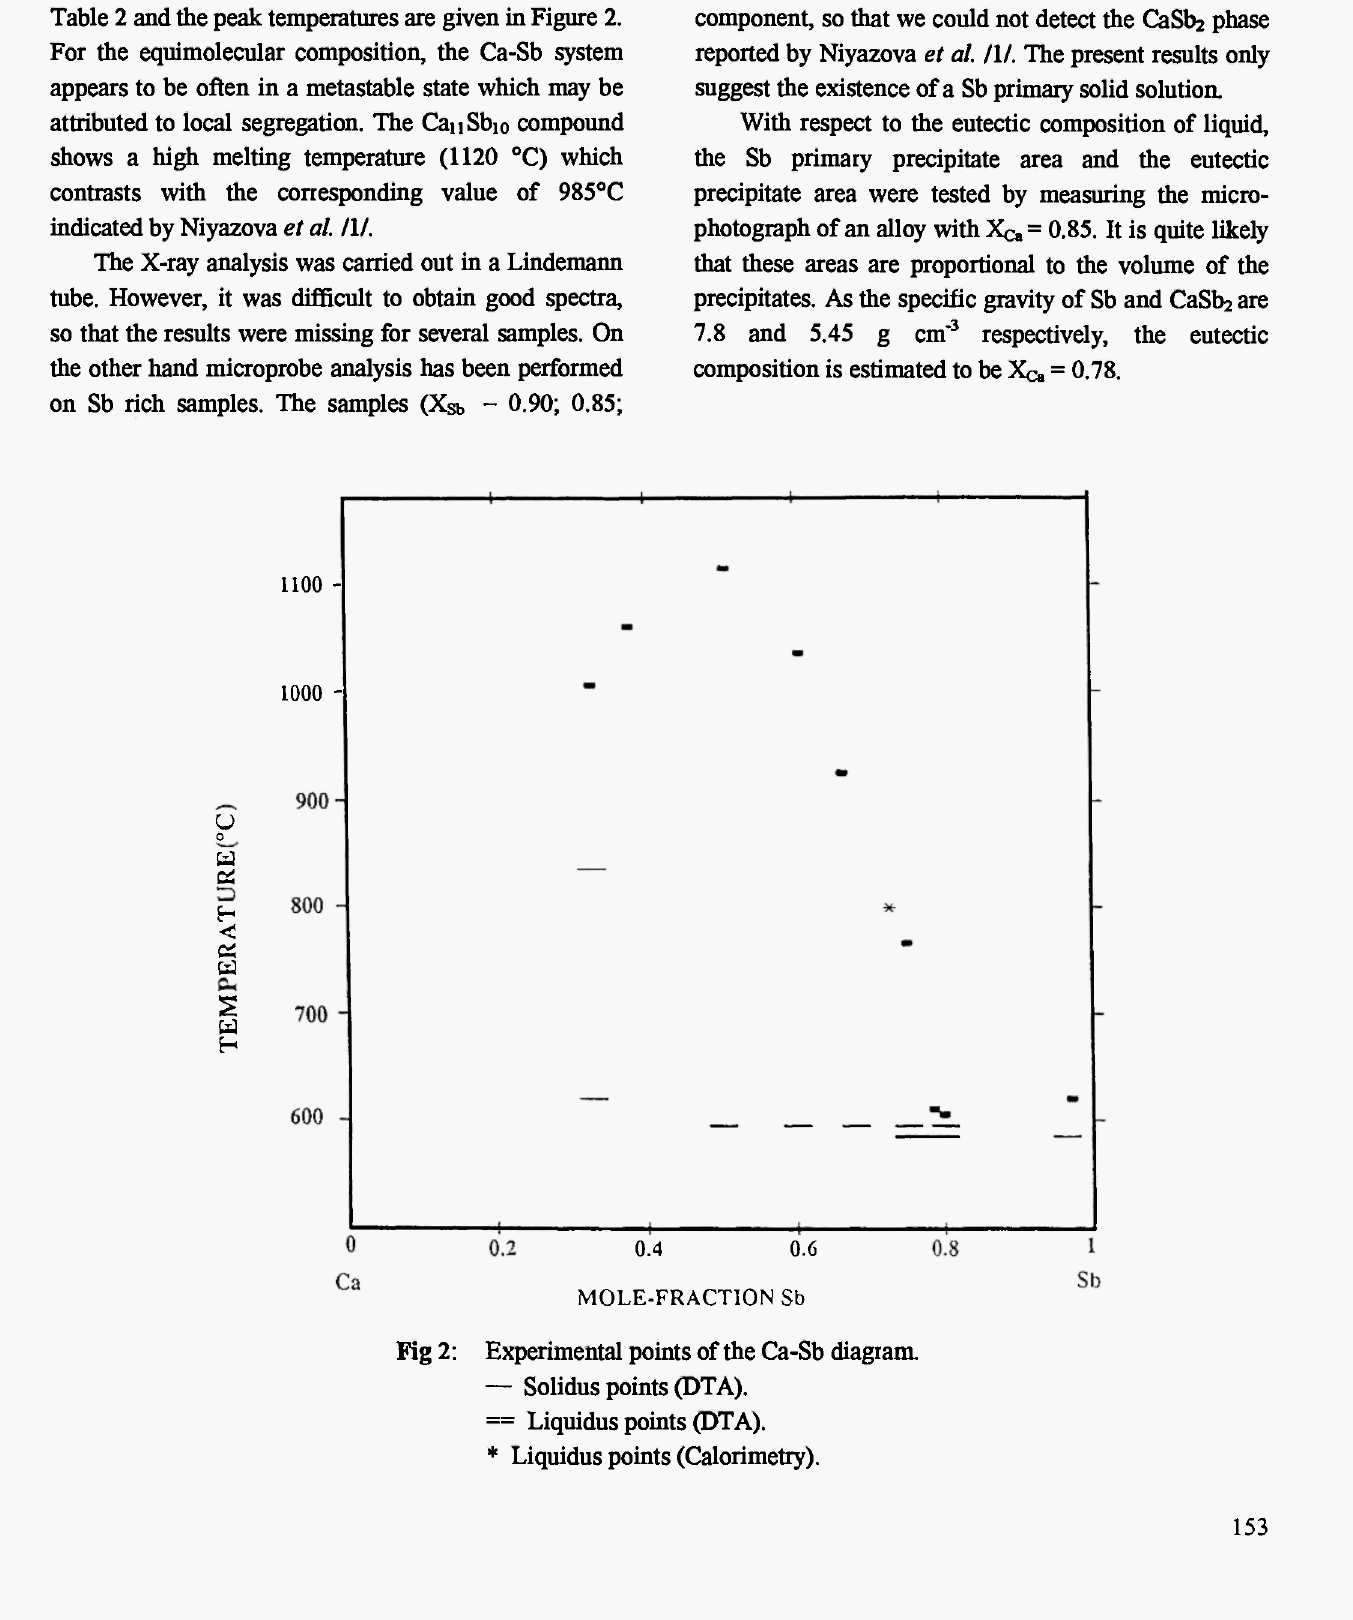
Fig 2: Experimental points of the Ca-Sb diagram — Solidus points (DTA). == Liquidus points (DTA). * Liquidus points